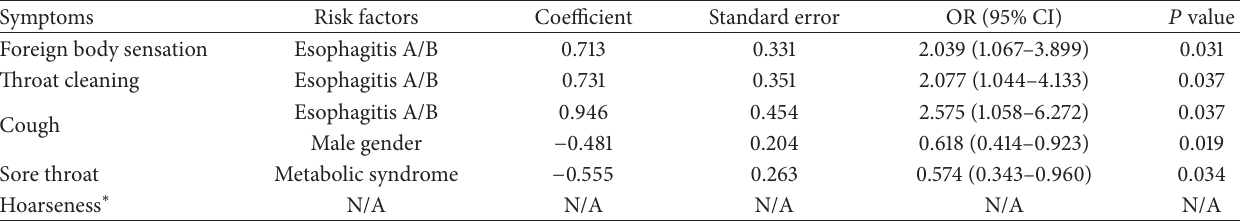
Table 4: Independent factors for extragastroesophageal symptoms in patients with mild erosive esophagitis, severe erosive esophagitis, and Barrett’s